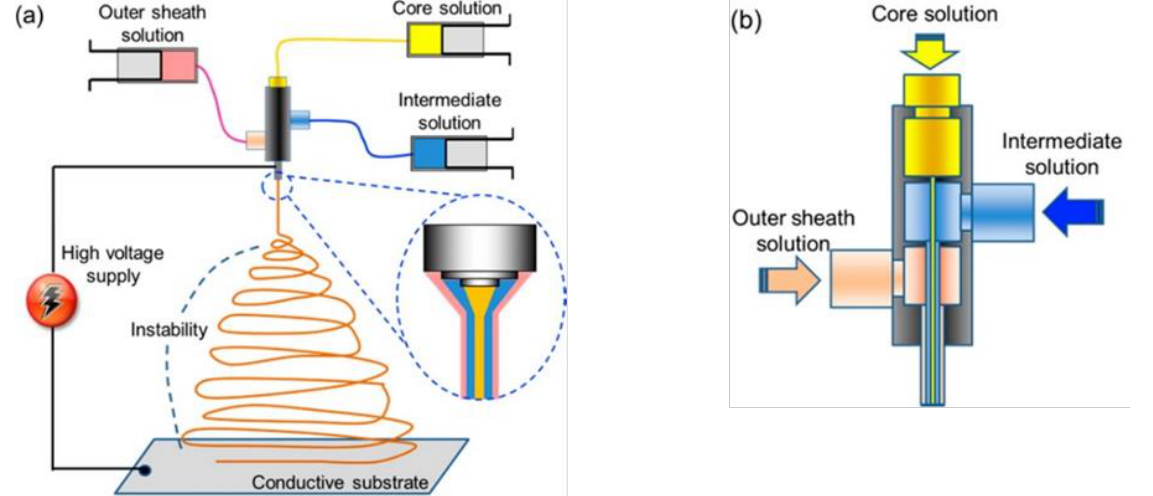
Figure 10. Triaxial electrospinning: ( a ) basic mechanism, ( b ) triaxial nozzle. Reproduced with permission from [115]. Copyright 2013 American Chemical Society.